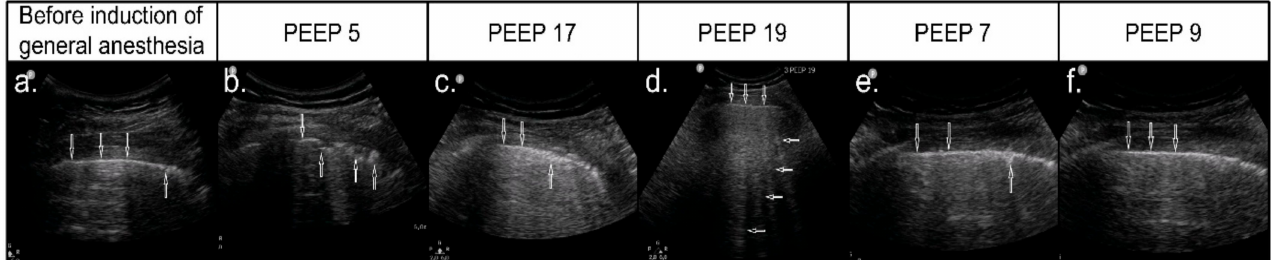
Figure 4. Recruitment process with an incomplete ultrasound effect. ( a ) LUS image before anesthesia—normal, hyperechoic pleural line ( ↓ ) and small abnormalities within the pleural line ( ↑ ) with small subpleural consolidations, as in segmental atelectasis; ( b ) control assessment after the induction of anesthesia, at PEEP 5cmH 2 O—blurred fragmented pleural line ( ↓ ) with hypoechoic subpleural consolidations ( ↑ ), image typical of atelectasis; ( c ) when increasing PEEP to 17cmH 2 O— persistent ultrasound features of atelectasis with a visible reduction in subpleural consolidations ( ↑ ); ( d ) when achieving PEEP value of 19cmH 2 O—continuous pleural line ( ↓ ) with multiple B-Line artifacts B ( ← ); ( e ) when reducing pressures, PEEP 9cmH 2 O—segmental disturbances in the pleural line continuity ( ↑ ) visible again—initial image of atelectasis; ( f ) after increasing end-expiratory pressure by 2cmH 2 O, to 9cmH 2 O, improvement in the pleural line image and better lung aeration were